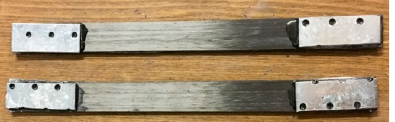
Figure 1. Specimens of lamellas for tensile testing.